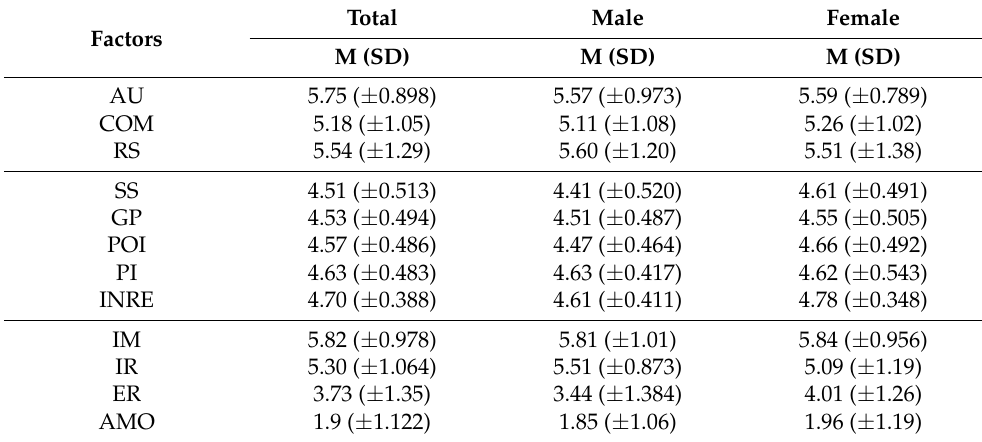
Table 1. General descriptive statistics: mean and standard variation by gender. Factors